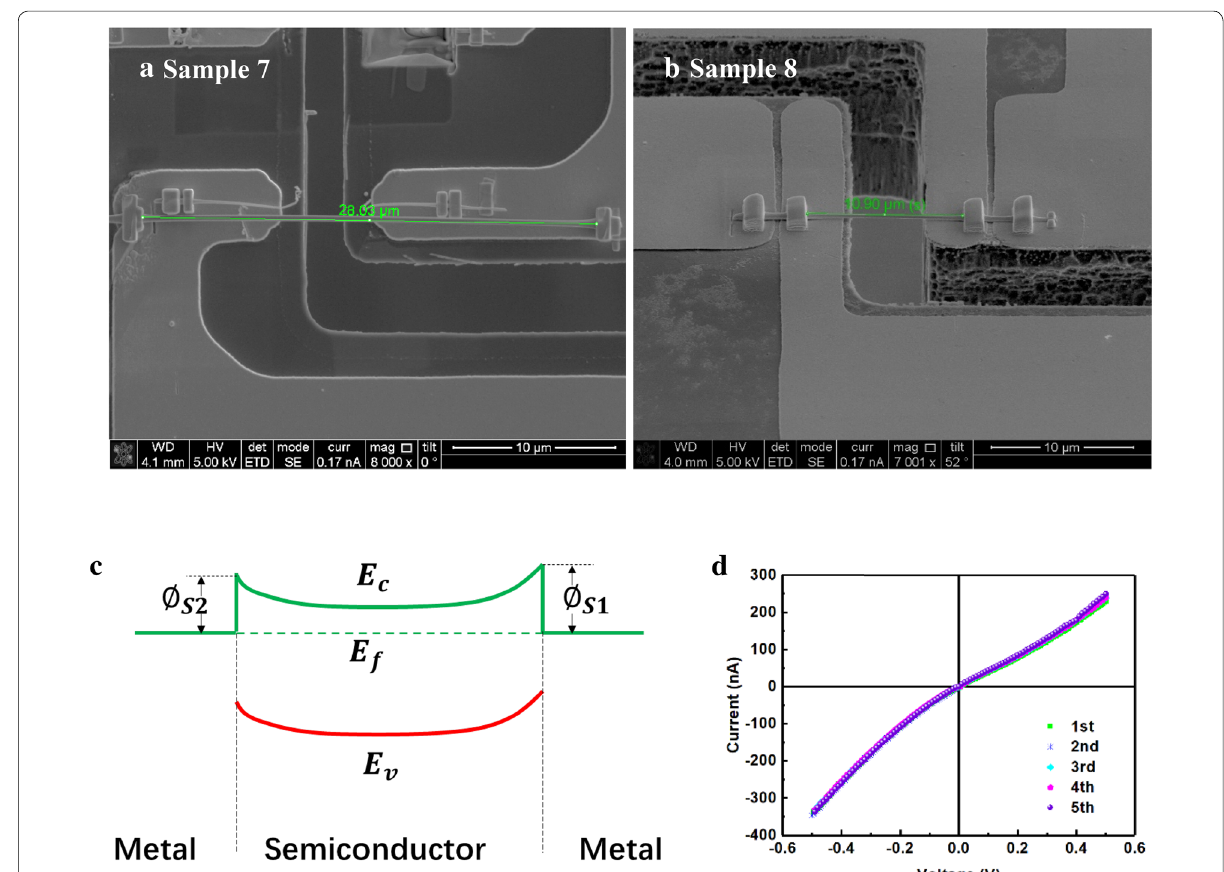
Fig. 4 a Sample 7 and b sample 8 were prepared for piezoelectric test. c Schematic of the energy band diagram of the two electrodes of a GaN nanocolumn, d the repeat electrical curves in sample